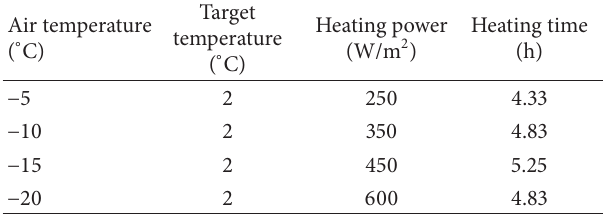
Table 4: Optimal preheating time without thermal insulation layer.